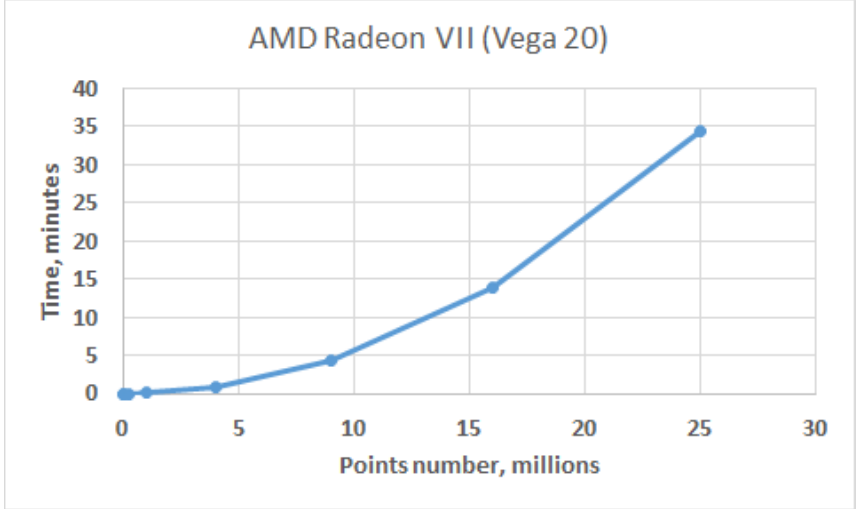
Figure 7. Dependence of calculation time with the GPU AMD Radeon VII on the number of field evaluation points.